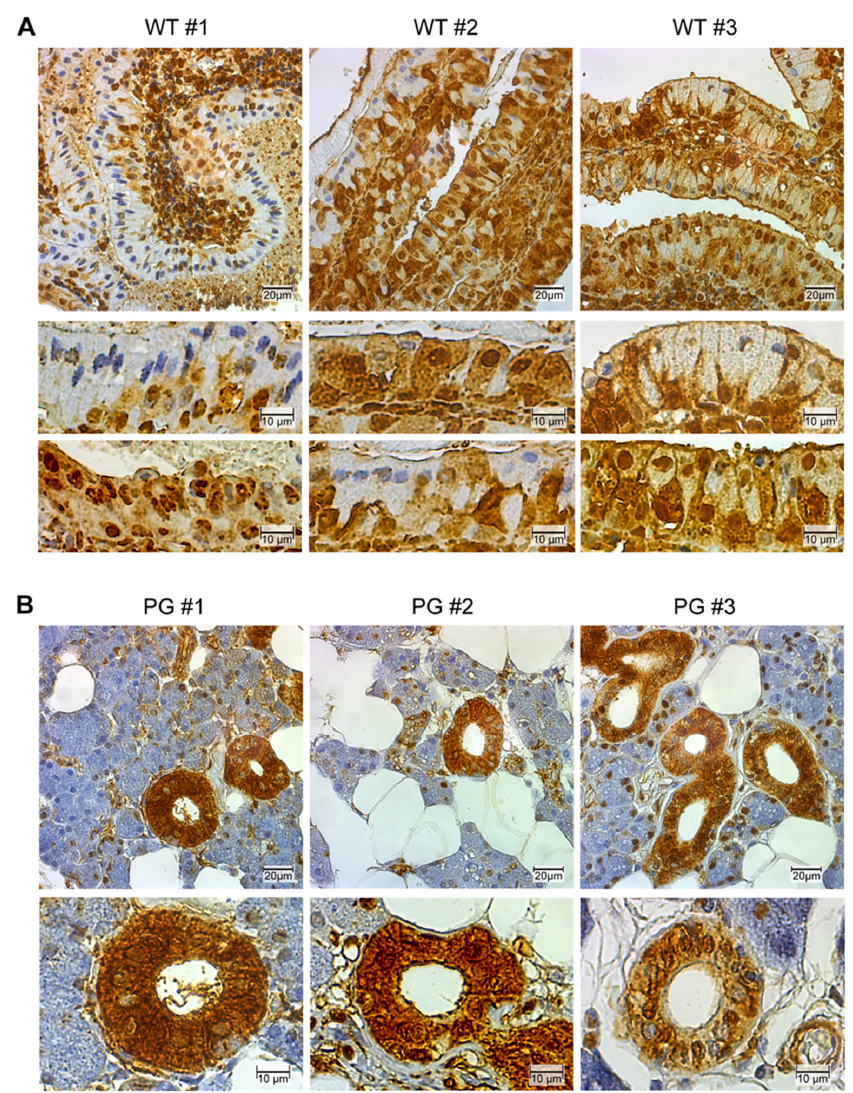
Figure 2. GAPDH expression in Warthin tumors and normal parotid glands. Shown are representative GAPDH immunostainings of ( A ) Warthin tumors (WT #1–3) and ( B ) normal parotid glands (PG #1–3). Note the strong and mostly homogeneous distribution of GAPDH in the cytoplasm and nuclei of ductal cells in normal PG and the heterogeneous “spotted” staining pattern in Warthin tumor oncocytes. Three major phenotypes can be seen in Warthin tumor oncocytes; cells with cytoplasmic and nuclear GAPDH; cells with only nuclear GAPDH; and GAPDH negative cells (mouse anti GAPDH, clone